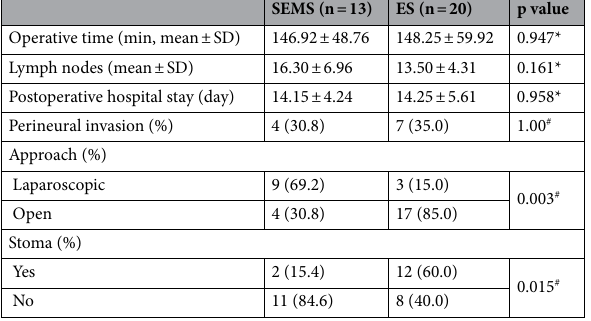
Table 2. Operative outcomes. *t test. # Chi-square test or fisher’s exact test.